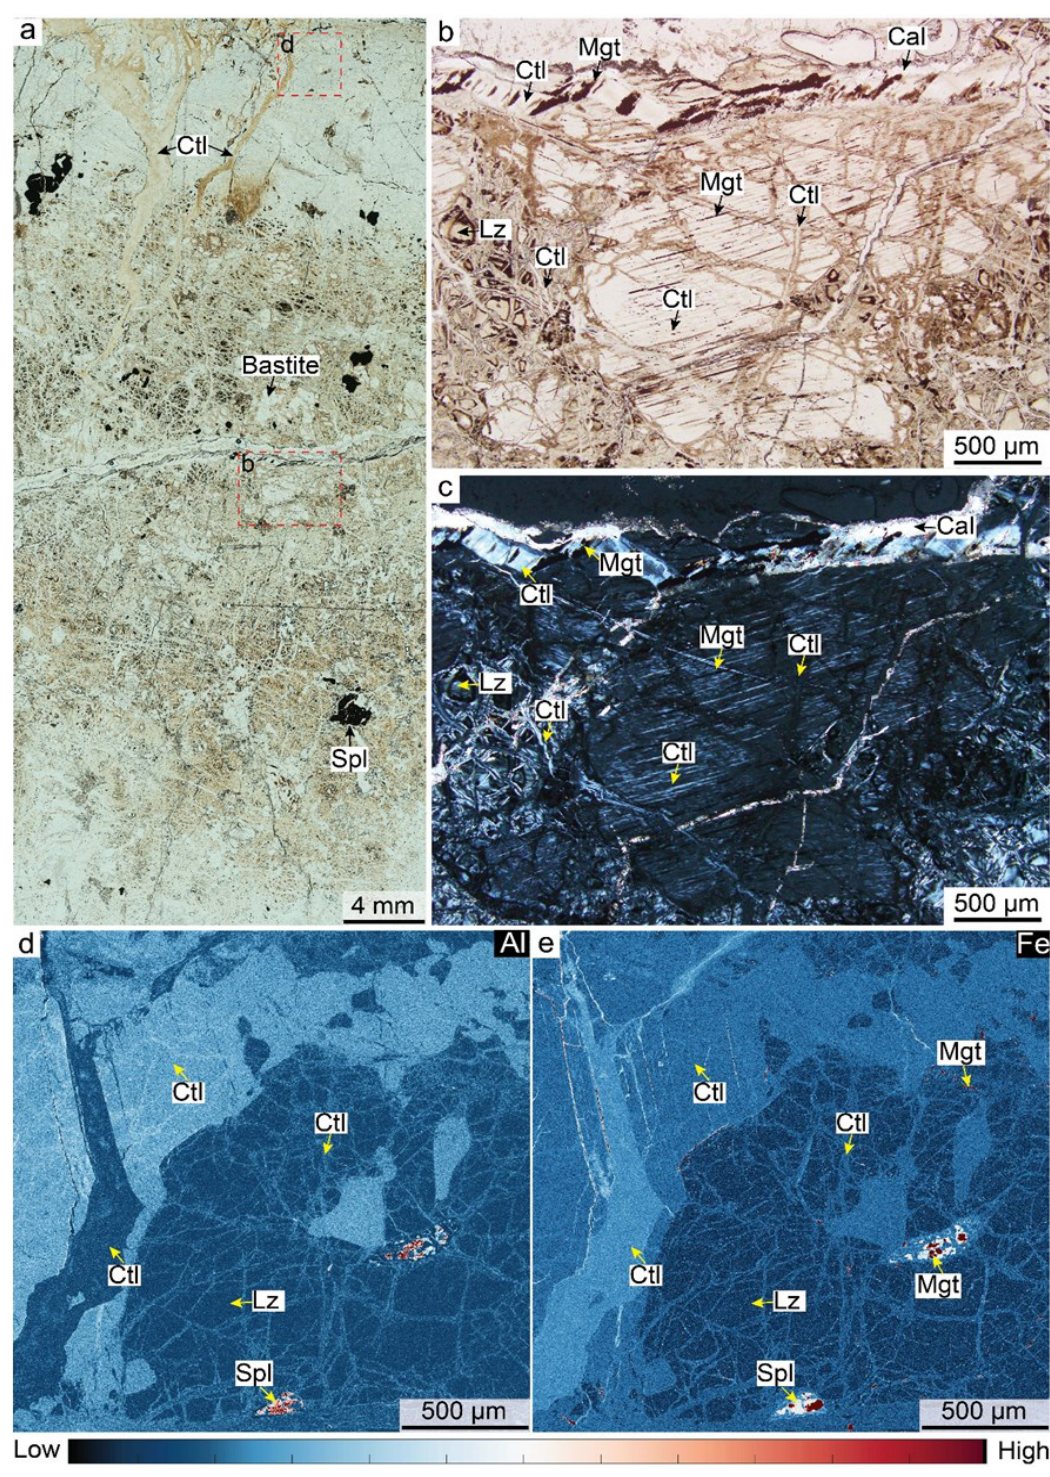
Fig. 3. Microstructure of a representative serpentinite sample. (a) Photomicrograph of a representative sample under plane-polarized light. Red dashed rectangles indicate the areas shown in (b) and (d). (b) and (c) Bastite and vein chrysotile with mesh textured lizardite under plane-polarized light and cross-polarized light, respectively. (d) and (e) Al and Fe mappings, respectively. The large chrysotile vein, the chrysotile bastite, and the lizardite mesh texture core have different Al and Fe contents. Ctl = chrysotile; Lz = lizardite; Mgt = magnetite, Spl = spinel, Cal =